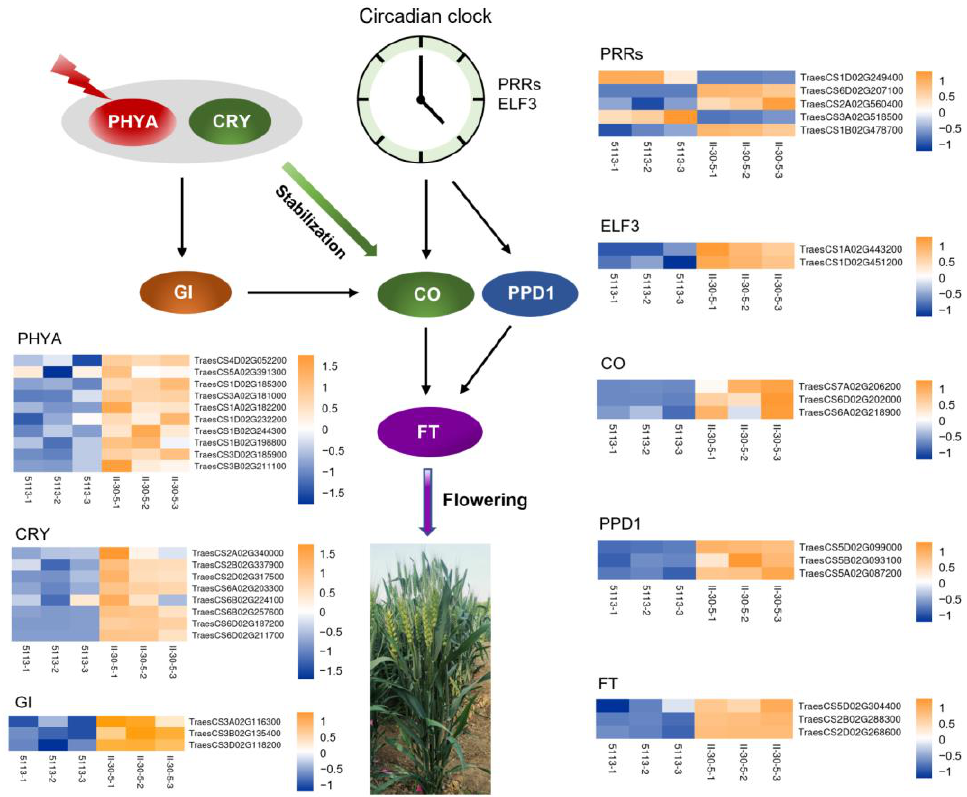
Figure 5. Schematic diagram of the flowering regulation pathway involving DEGs in the addition lines 5113 and II-30-5.